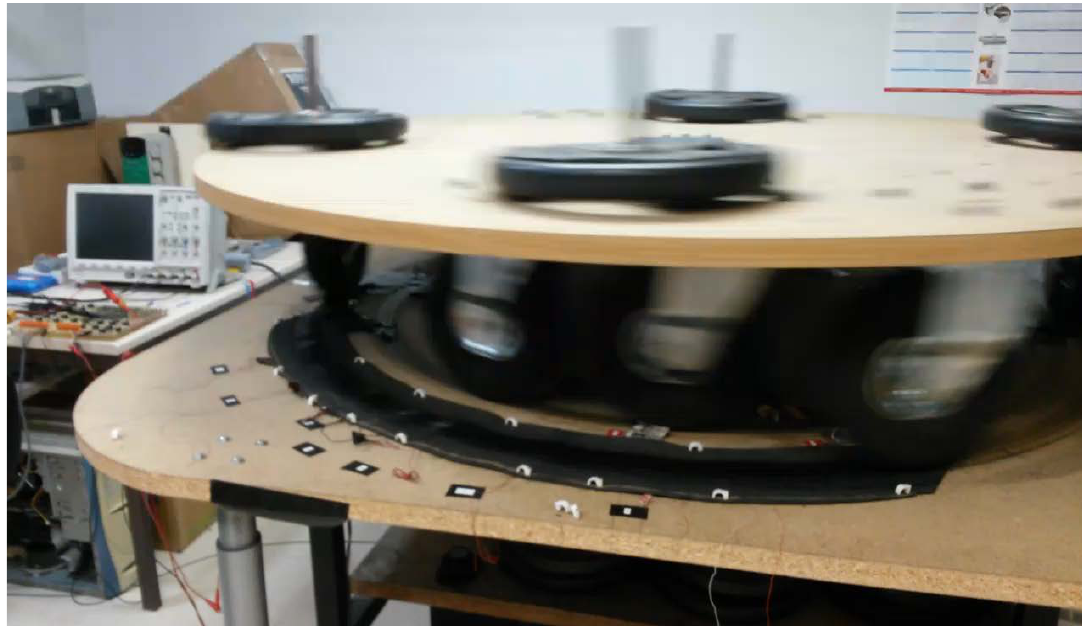
Figure 2. Piezoelectric characterization system in action.